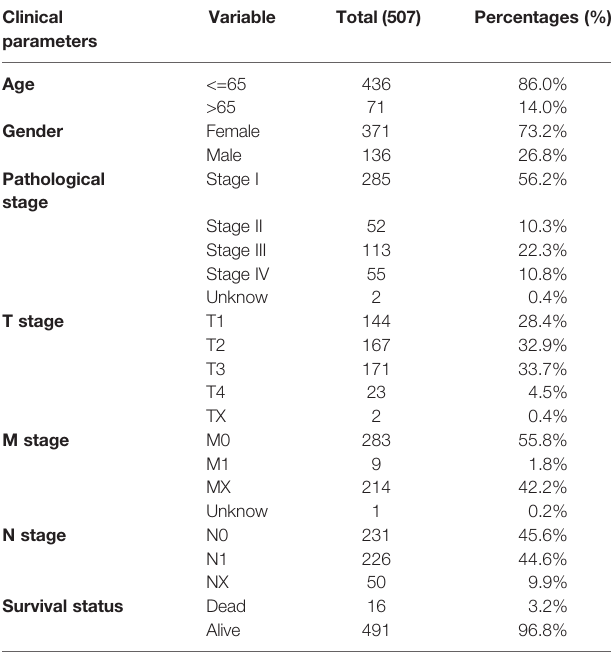
TABLE 1 | Clinicopathological characteristic of 507 patients with thyroid carcinoma from TCGA database. Clinical parameters